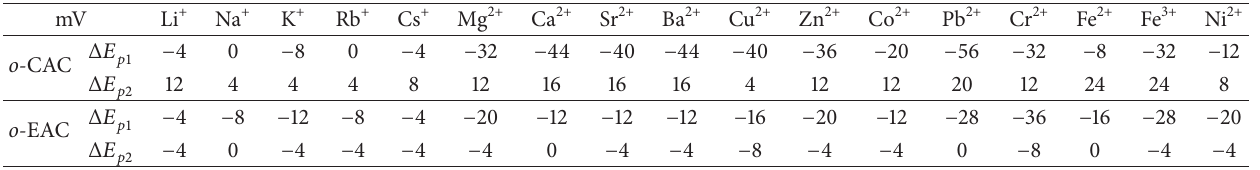
Table 2: Anodic peak potential differences between o -CAC or o -EAC and o -CAC– or o -EAC–metal ion complexes in